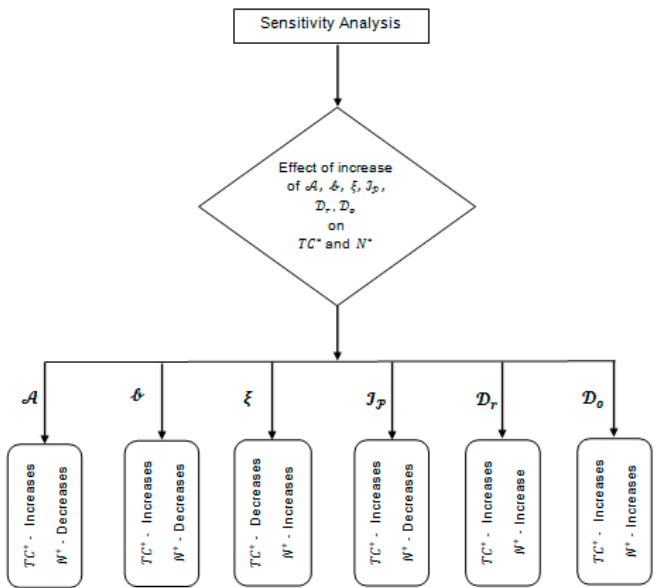
Figure 3. Flow of the sensitivity analysis.